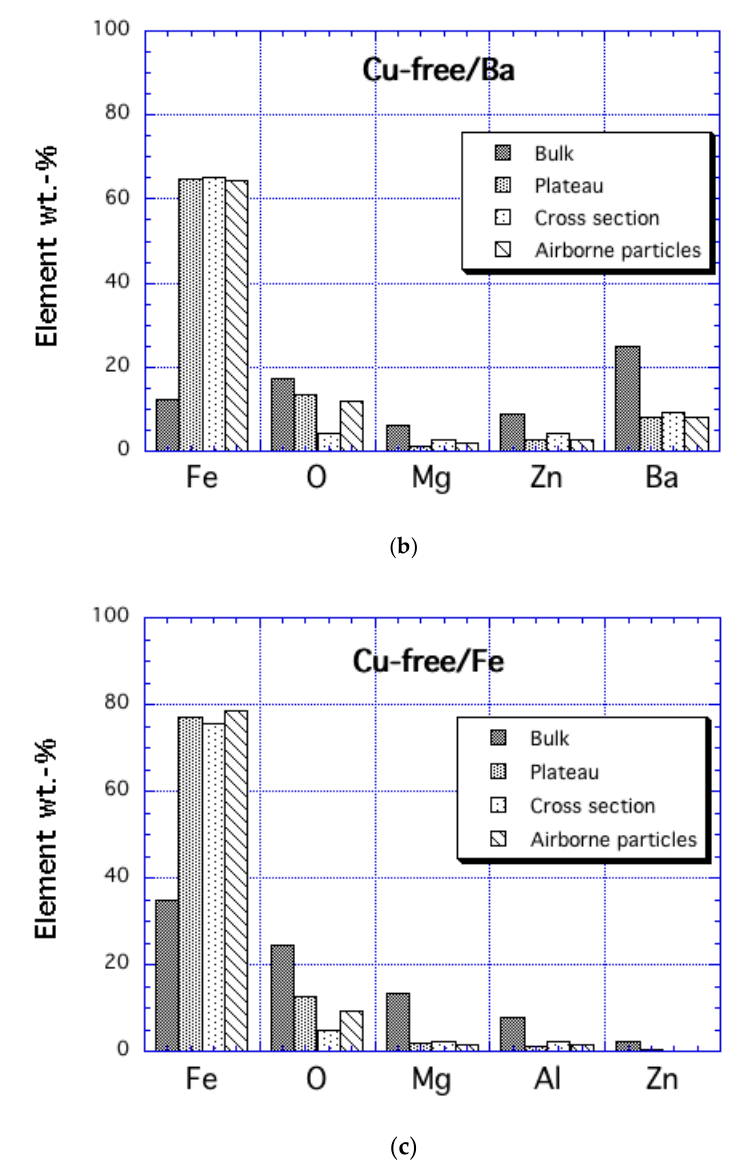
Figure 9. Comparison of the elemental composition found on bulk material, secondary plateau on the pin surface (plateau), secondary plateau on the pin cross section (cross section) and airborne particles for ( a ) Cu-free/A, ( b ) Cu-free/Ba and ( c ) Cu-free/Fe friction materials.